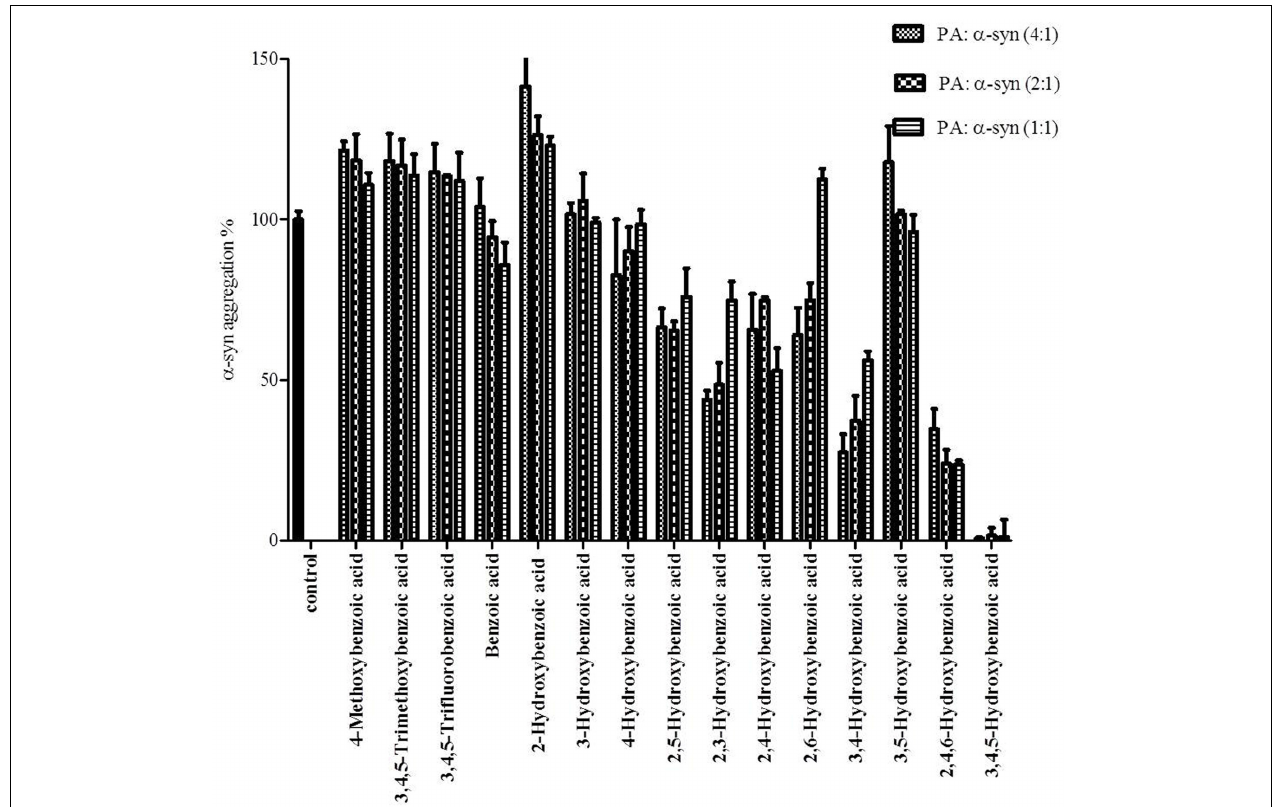
FIGURE 8 | Effect of different benzoic acid derivatives (phenolic acids, PA) and the effect of methoxy and fluoro groups in benzoic acid derivatives on α -syn fibrillation. Samples of α -syn (25 μ M) were incubated alone or in the presence of different benzoic acid derivatives (PA: α -syn molar ratios of